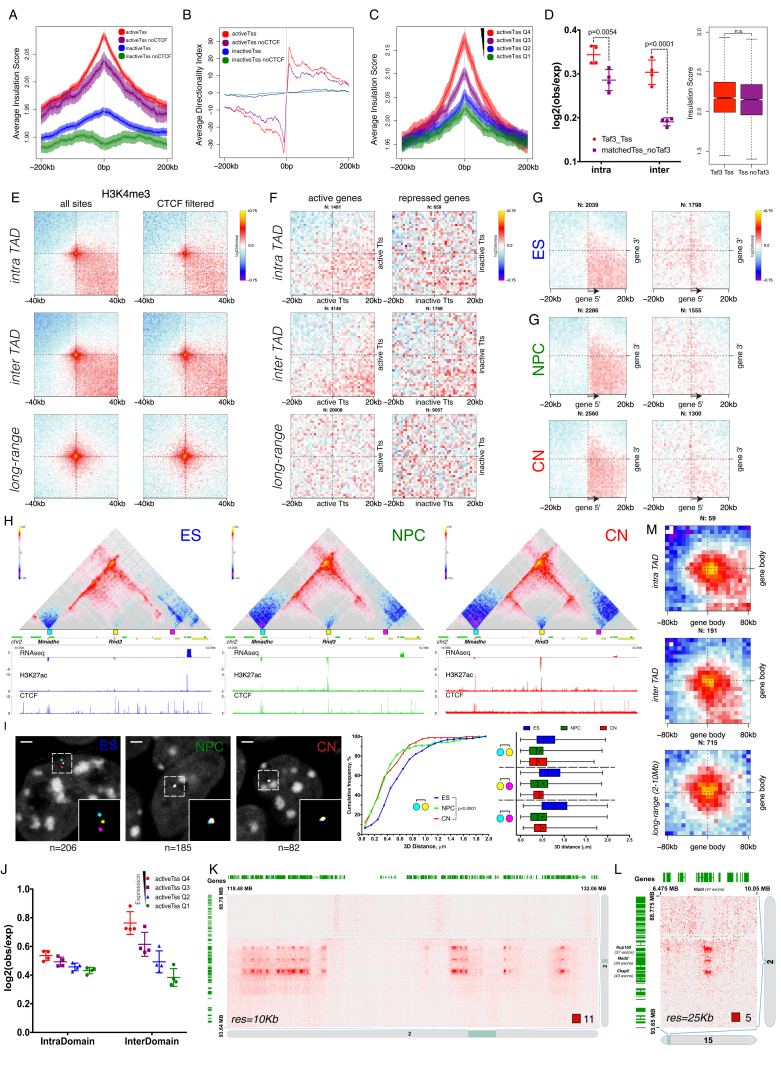
Transcription-Associated Contacts and Local Chromatin Insulation around Gene Promoters, Related to Figure 4(A) Average insulation score centered on gene promoters in ESs. Lines show mean values, while dark and light shaded ribbons represent SD and 95%CI respectively.(B) Average DI centered on different types of gene promoters in NPCs.(C) Average insulation score centered on active gene promoters in ESs separated into quartiles based on expression values in ESs.(D) Quantification of the contact enrichment and insulation at Tss which are bound by Taf3 or expression matched Tss which are not bound Taf3 in ESs. Statistics are calculated using two-way Anova with Sidak’s correction (contacts) or the Wilcoxon’s unpaired test (insulation).(E) Aggregate Hi-C maps in NPCs between pairs of either all H3K4me3 sites or filtered for the presence of CTCF binding site within ± 5Kb.(F) Aggregate Hi-C contact maps around pairs of gene transcription termination sites separated into active or inactive based on expression.(G) Aggregate Hi-C maps showing the interactions between matched gene promoters and transcription termination sites. Only genes longer than 50Kb and not spanning a TAD border are examined.(H) Hi-C contact maps showing ∼2.5Mb region around the Rnd3 gene. Regions examined by FISH are indicated with colored squares.(I) Representative 3D- DNA FISH images (z-slices) and quantifications showing the decrease in distance between the regions shown in (H).(J) Quantification of the contact enrichment between pairs of active gene promoters separated into quartiles based on expression. Data are represented as a scatter dot plot showing the mean ± SD.(K and L) Cluster of long-range chromatin loops either in cis (K) or in trans (L), visualized using Juicebox (Rao et al., 2014).(M) Aggregate Hi-C maps between pairs of genes in the top expression and number of exons quantile based on Figure 4J.